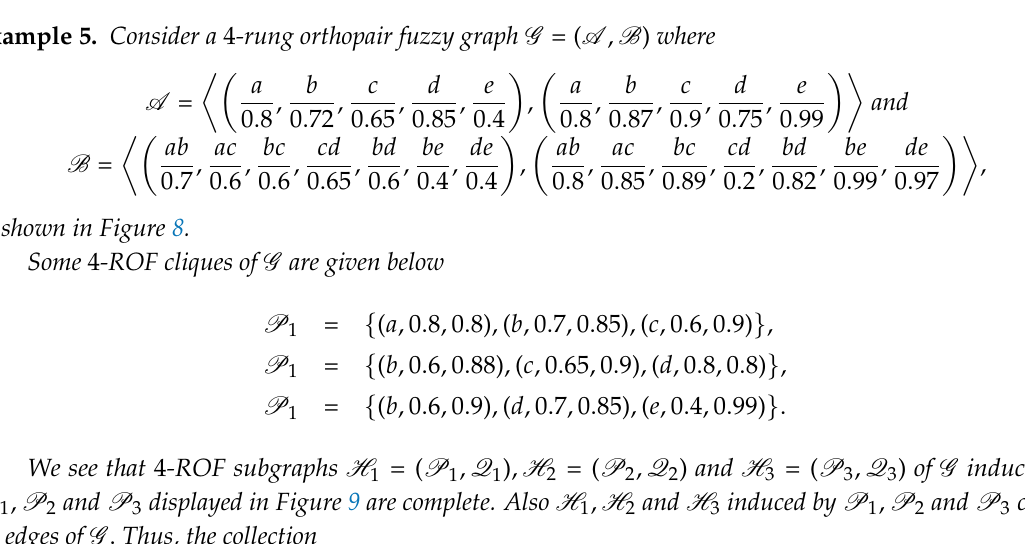
Table 1: Quality of Products Company